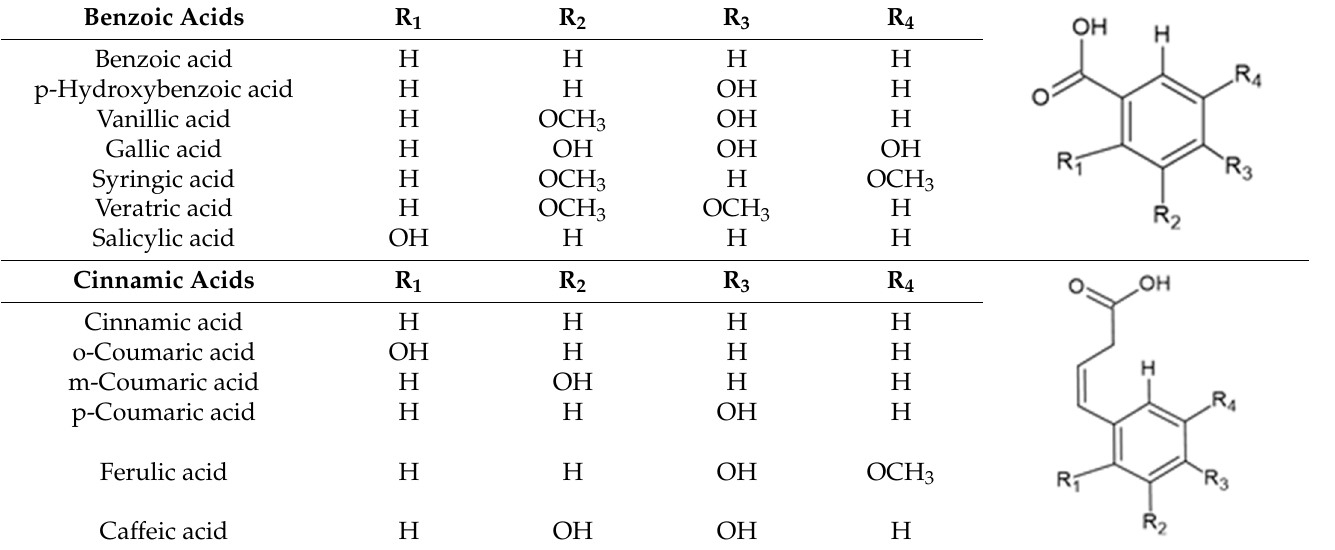
Figure 1. The main classes and subclasses of phenolic compounds.